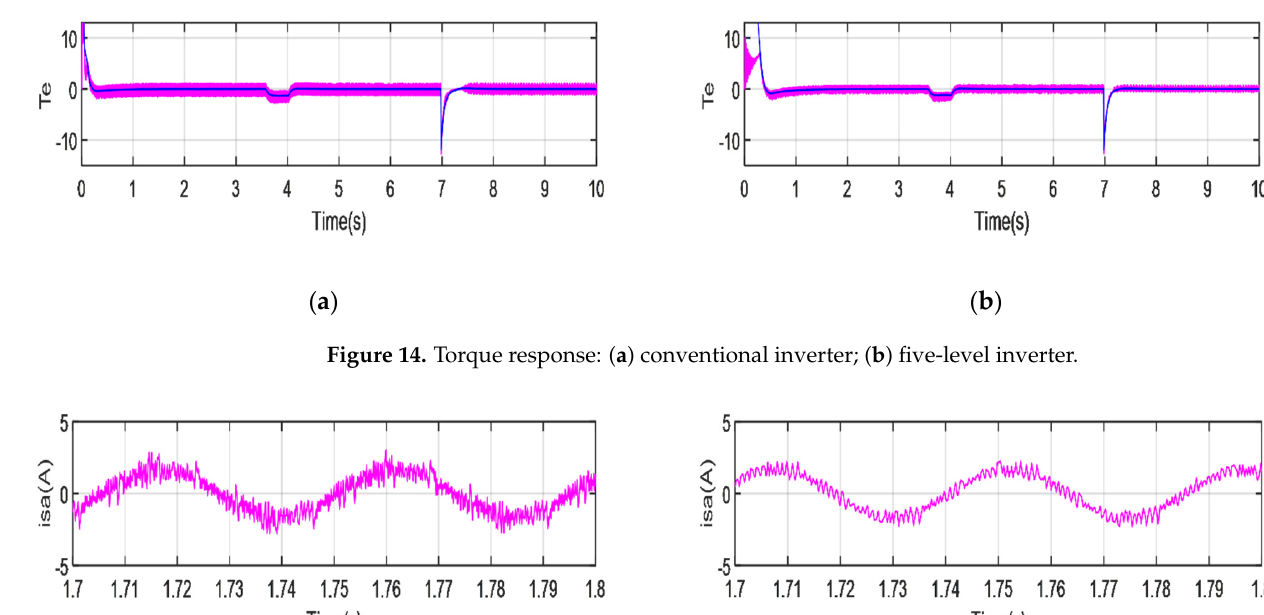
Figure 15. Stator current: ( a ) conventional inverter; ( b ) five-level inverter.